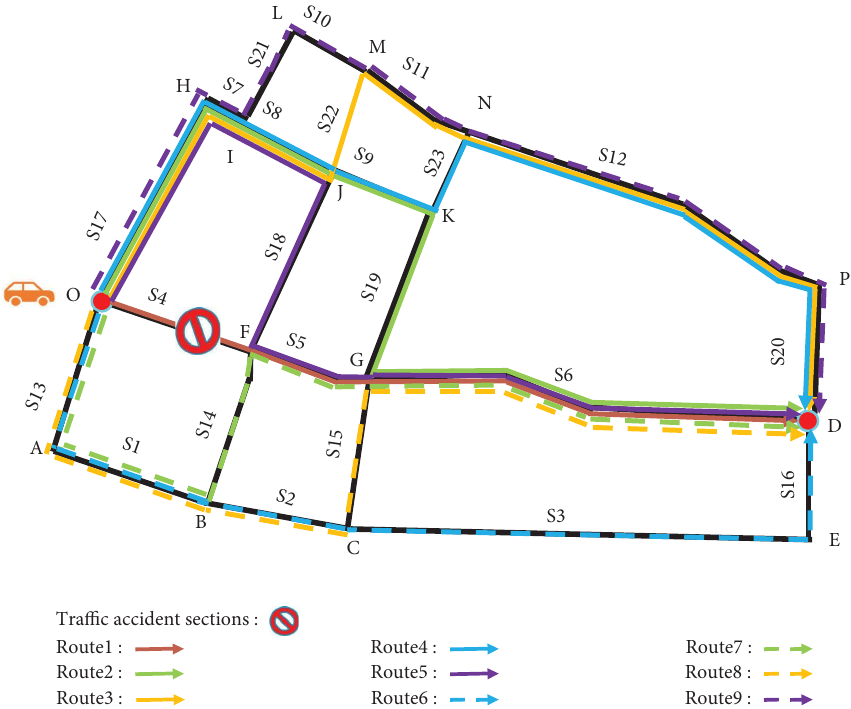
Figure 1: Experimental network topology and travel routes.